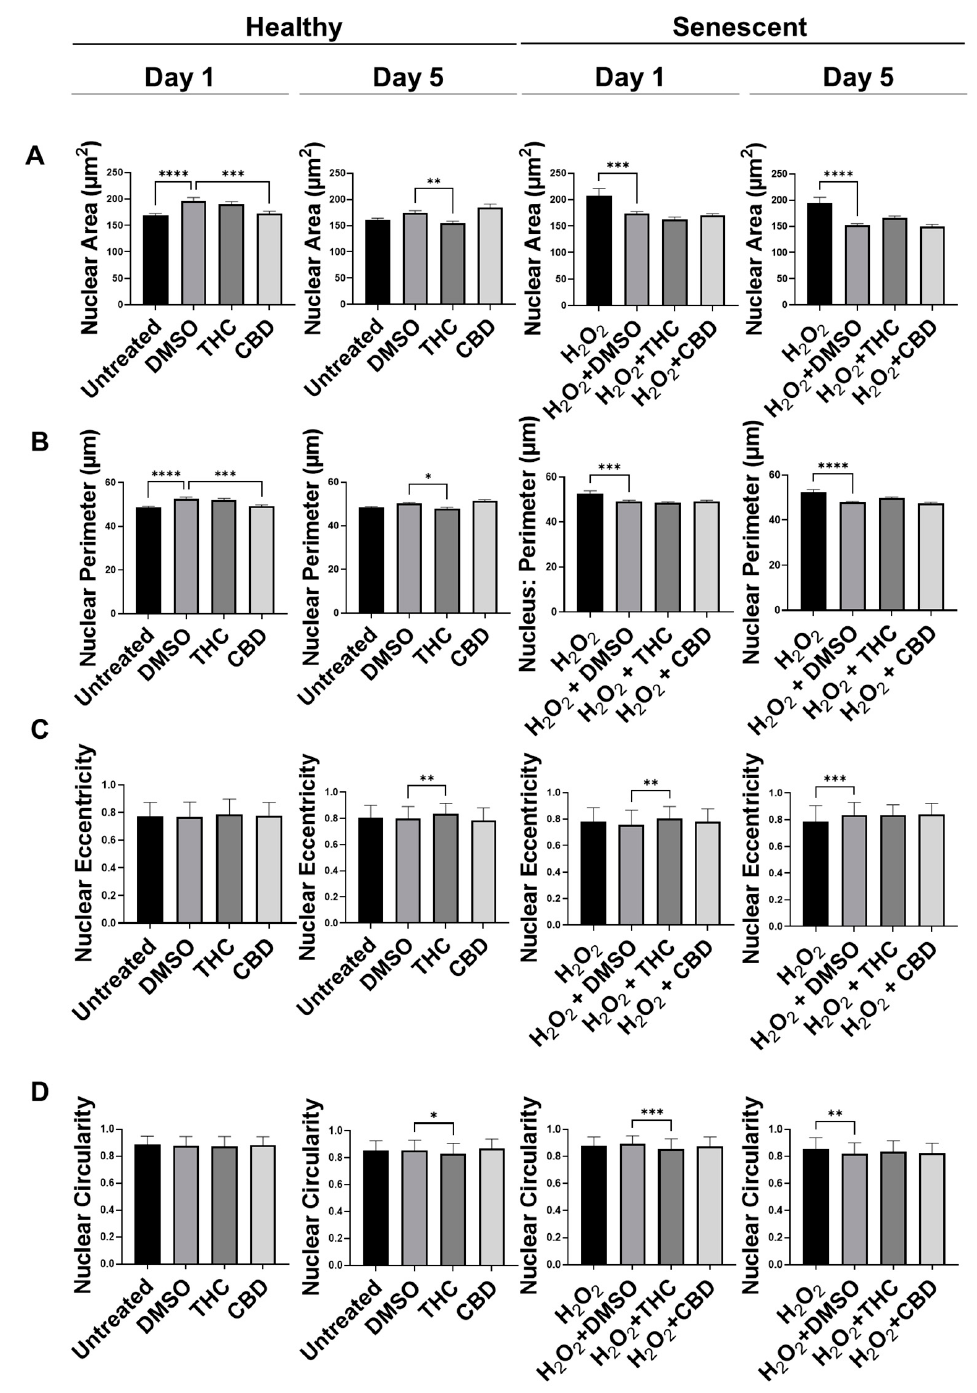
Figure 5. Nuclear parameters of healthy and SIPS DAPI-stained CCD-1064Sk dermal fibroblasts (PDL 24) exposed to phytocannabinoids. ( A ) Nuclear area, ( B ) nuclear perimeter, ( C ) nuclear eccentricity, and ( D ) nuclear circularity of healthy SIPS fibroblasts exposed to 2 µM of THC or CBD. Data were analyzed with an ANOVA test followed by a Dunnett’s post-hoc multiple comparison test compared to the vehicle ( n = 76–186). Bars represent mean ± SEM. Significance is indicated using the following scale: * p < 0.05, ** p < 0.01, *** p < 0.001, **** p < 0.0001. CBD, cannabidiol; DMSO, dimethyl sulfoxide (vehicle); SIPS, stress-induced premature senescence; THC, delta-9-tetrahydrocannabinol.